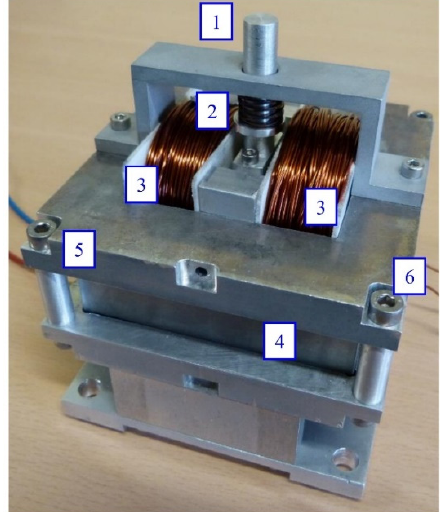
Figure 8. Second actuator design (1)—push rod, (2)—wave spring, (3)—coils, (4)—magnetic pole, (5)—aluminium body, (6)—screws, made of non-magnetic austenitic steel.